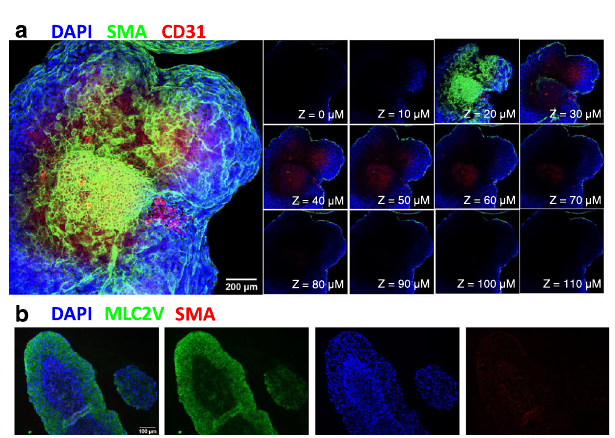
Fig. 7 PEC organization on CM aggregates. a z-stack images of the whole- mount PEC-CM aggregates were fl uorescent stained for SMA (green), CD31(red) and DAPI (blue) of after 15 days ( n = 1). Scale = 200 µ m. b Immunostaining of day 15 CM only aggregates for MLC2V (green), SMA (red) and DAPI (blue). n = 3 independent experiments, Scale bar = 100 µ